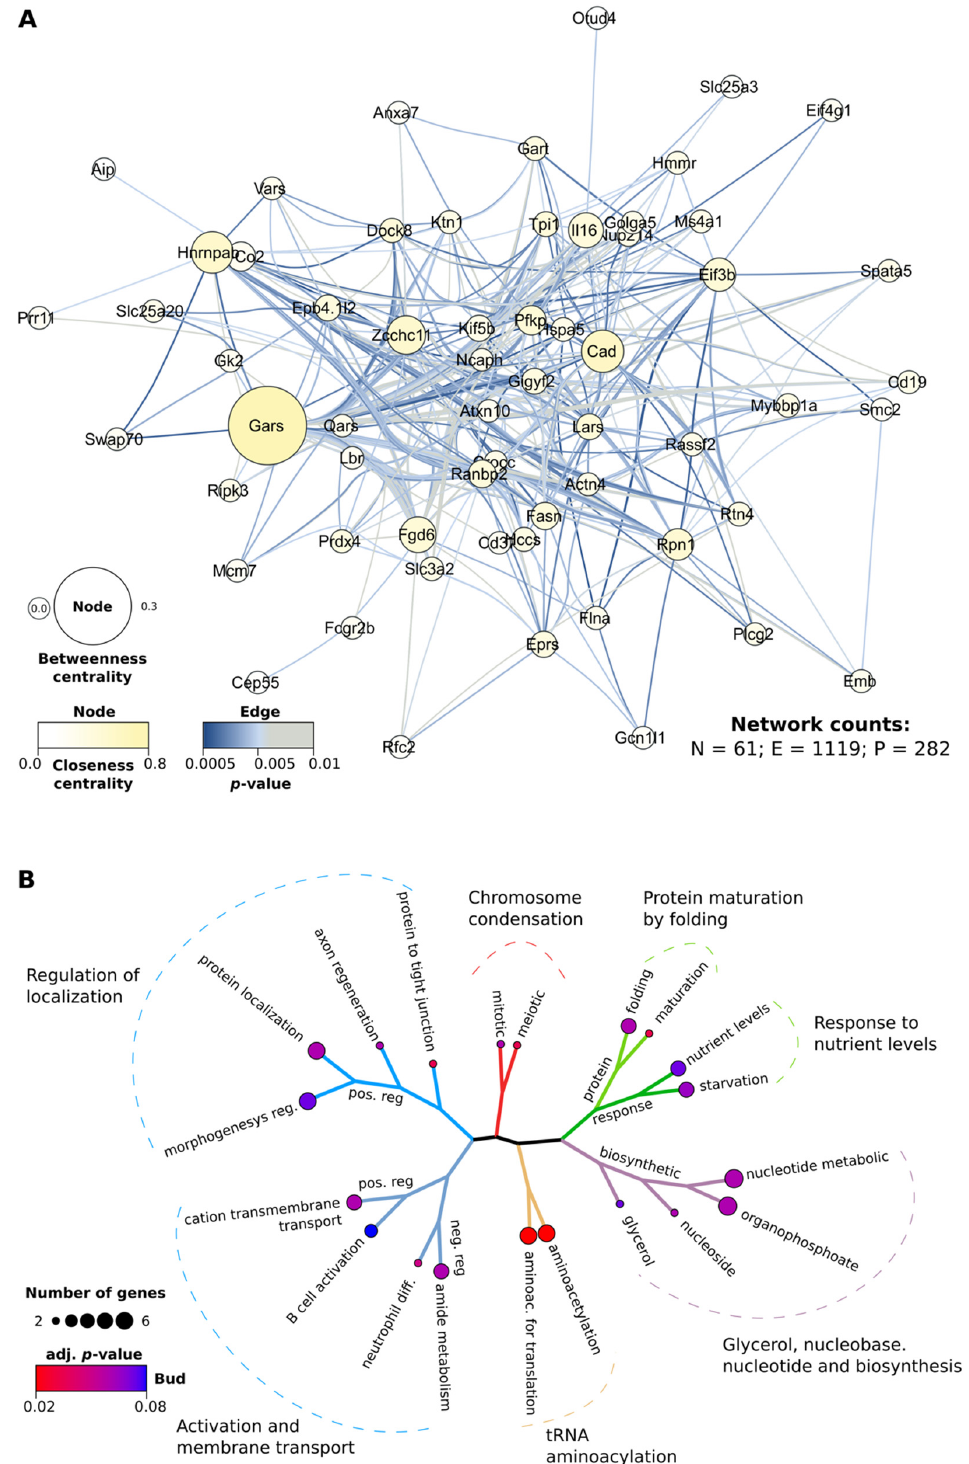
Figure 3. Proteins predicted to coevolve in the dataset of 324 proteins found to be located at the vicinity of the B cell membrane rafts. ( A ) Network analysis of the coevolving pairs. Number of nodes (N), pairs (P), and edges (E) are indicated. The size and colour of the nodes reflect betweenness and closeness centrality, respectively. The colour of the edges corresponds to the p-value of coevolution of each amino acid pair. ( B ) Gene ontology analysis of the protein network in ( A ). The cellular processes in which proteins are involved are indicated.